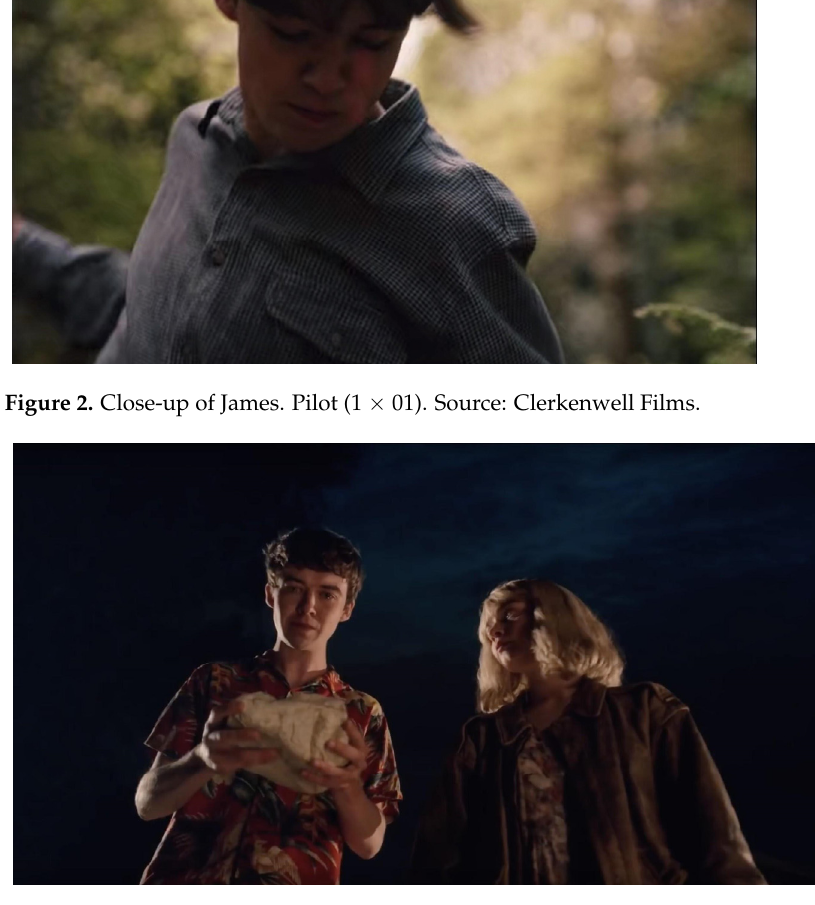
Figure 3. James and Alyssa killing a cat (1 × 07). Source: Clerkenwell Films